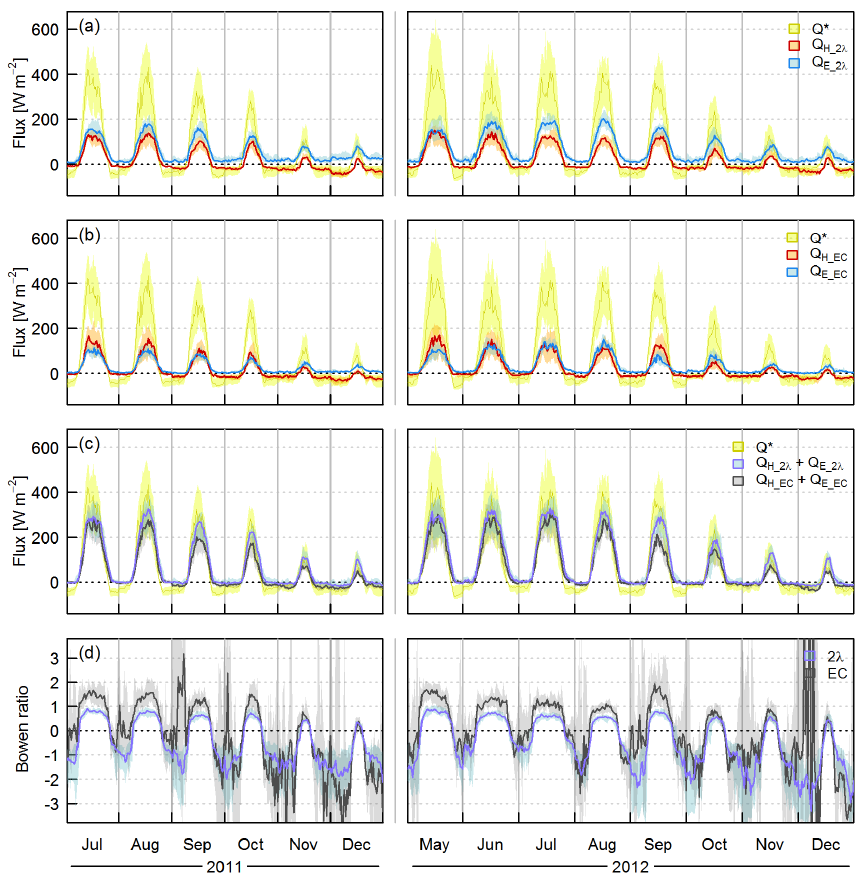
Figure 8. Monthly median diurnal cycles (lines) and inter-quartile ranges (shading) of sensible and latent heat fluxes determined using (a) two-wavelength scintillometry and (b) eddy covariance; (c) sum of the turbulent fluxes; and (d) Bowen ratio. The net all-wave radiation is also